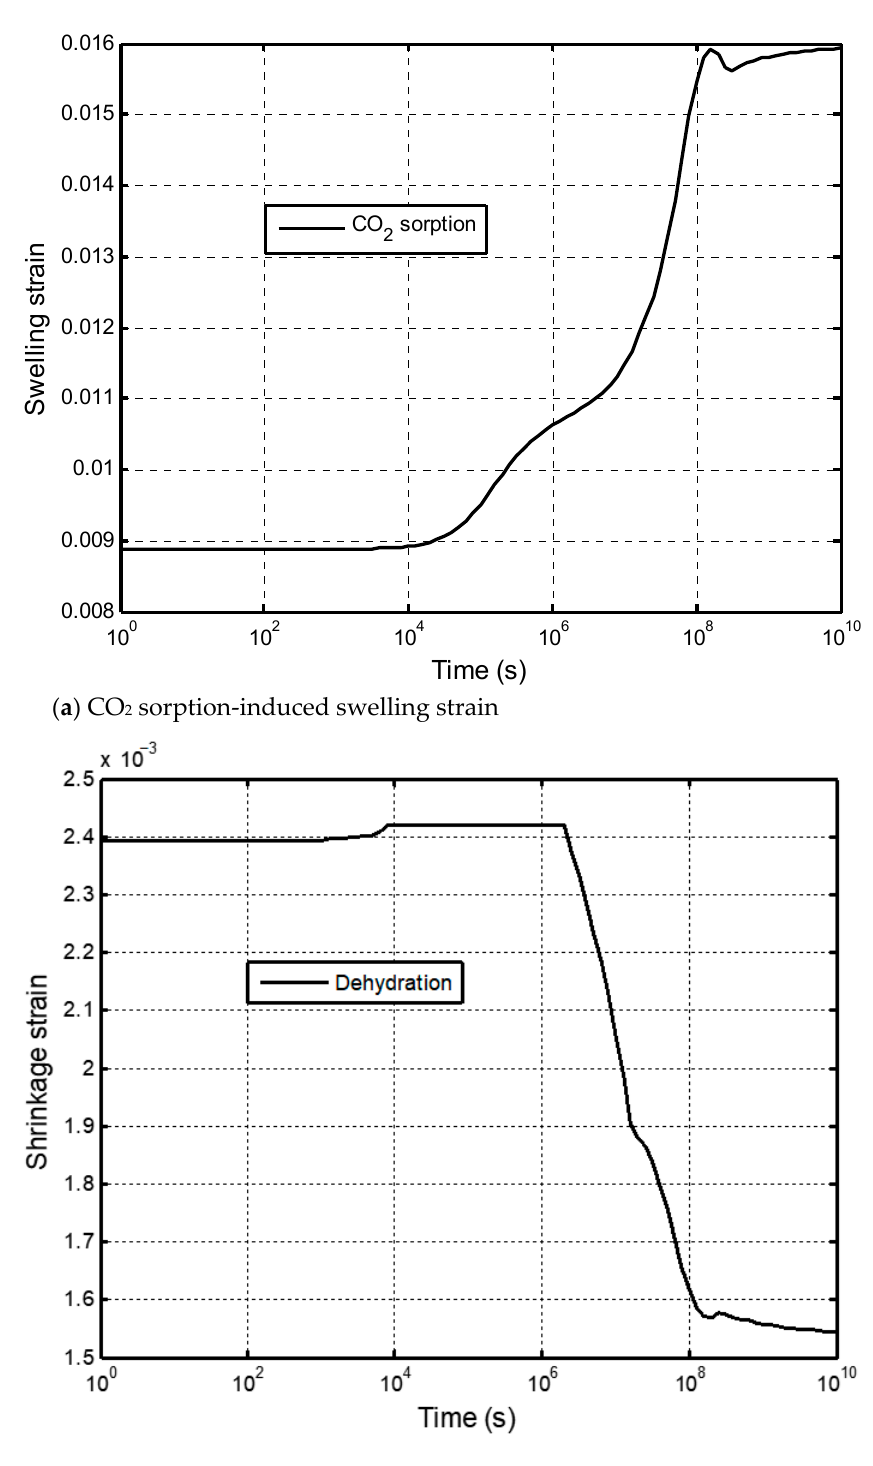
Figure 10. Swelling/shrinkage strain induced by two competitive factors at the observation point.